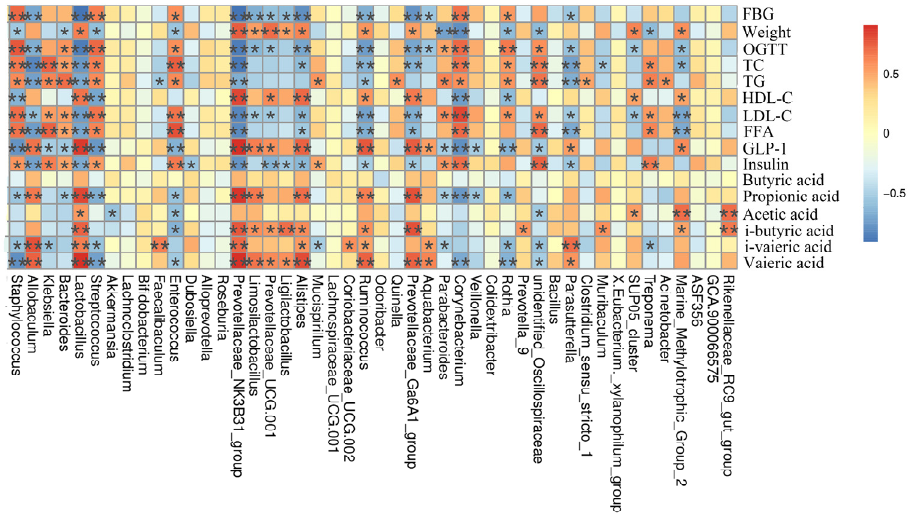
Figure 8. Spearman analysis between key bacterial genera and physiological indexes. * p < 0.05 and ** p < 0.05.